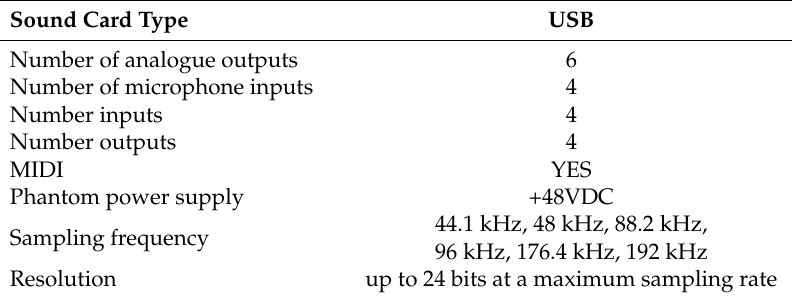
Table 1. Steinberg UR44 sound card